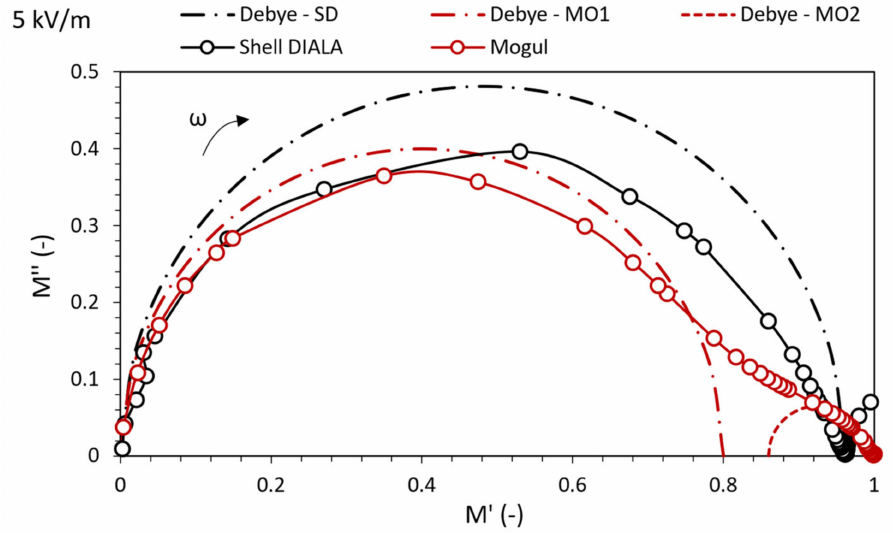
Figure 8. Comparison of electrical insulating oils of the intensity E of time-varying electric field 5 kV/m.